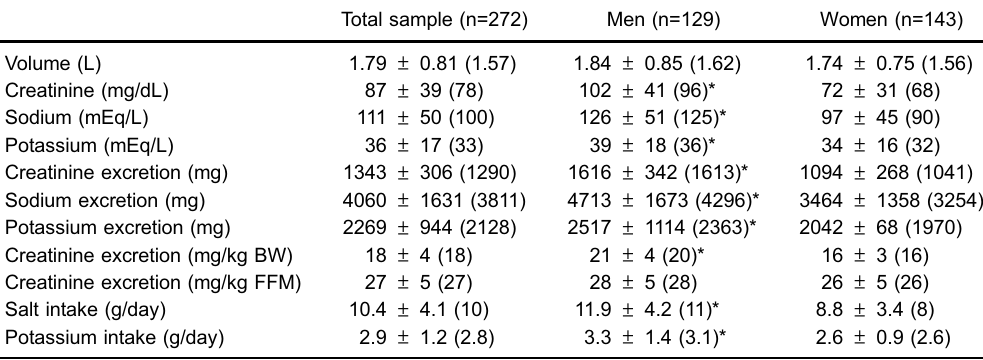
Table 1. Characteristics of 24-h urine in the total sample and strati fi cation by gender. Total sample